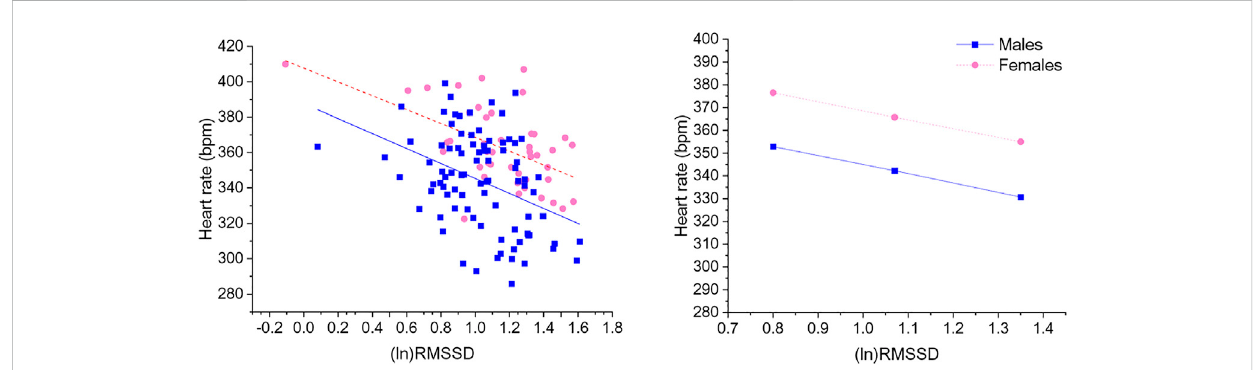
RMSSD = natural log-transformed root mean square of successive beat-to-beat interval